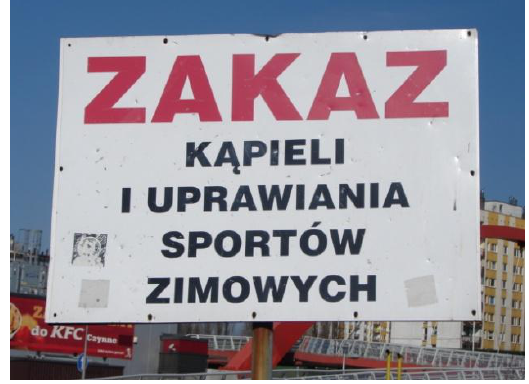
Fig. 6. Warning sign forbidding recreational use of the reservoir in the winter period ( R. Machowski